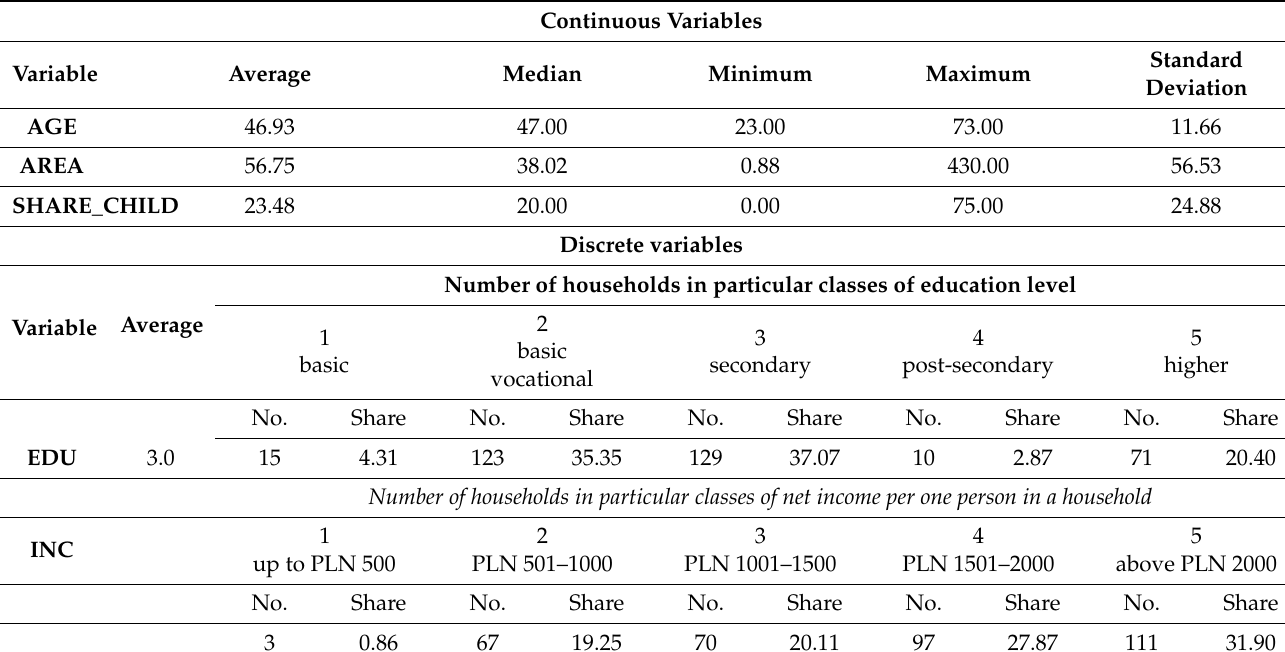
Table 2. Descriptive statistics of independent variables considered in the